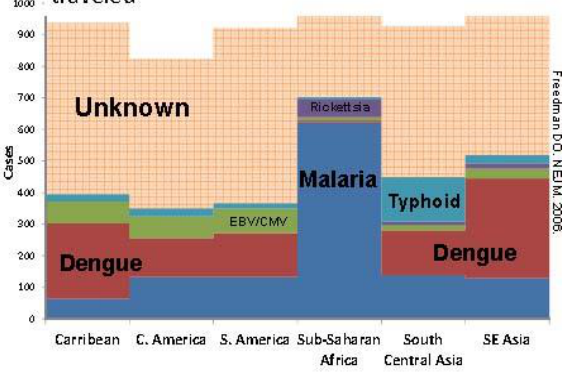
Figure 2. Etiology of fever according to region traveled [8] Thirdly, there has been tremendous growth in the field of vaccinology, with the release of new vaccines to prevent infections, some which are related to travel [19].